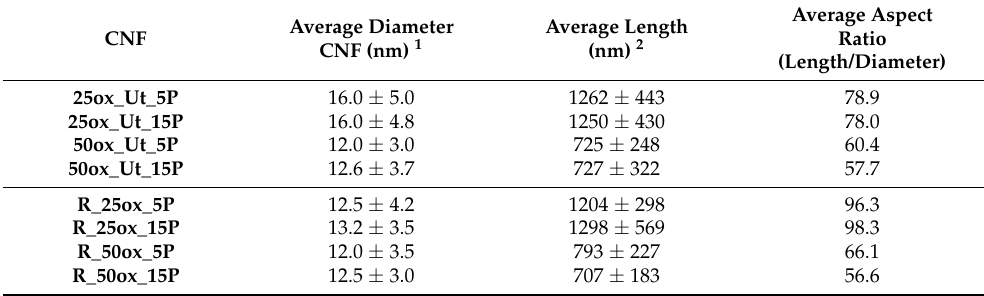
Table 5. Average diameter of CNF determined by TEM.